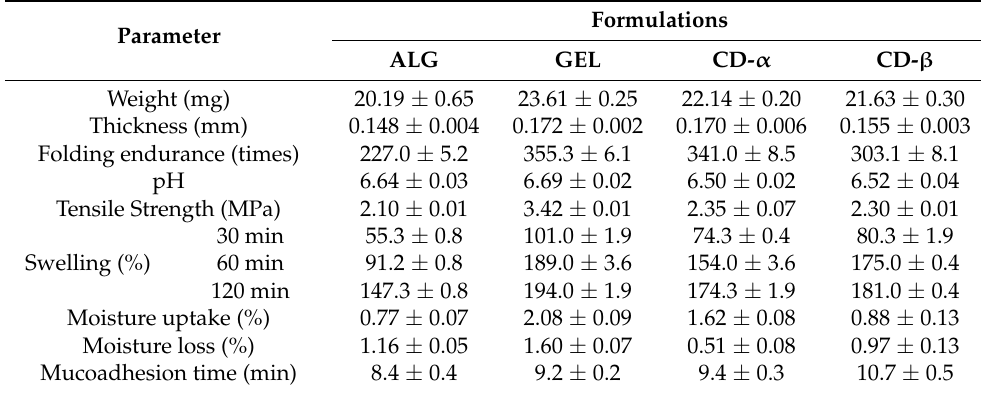
Table 2. The physicochemical-mechanical characteristic of developed